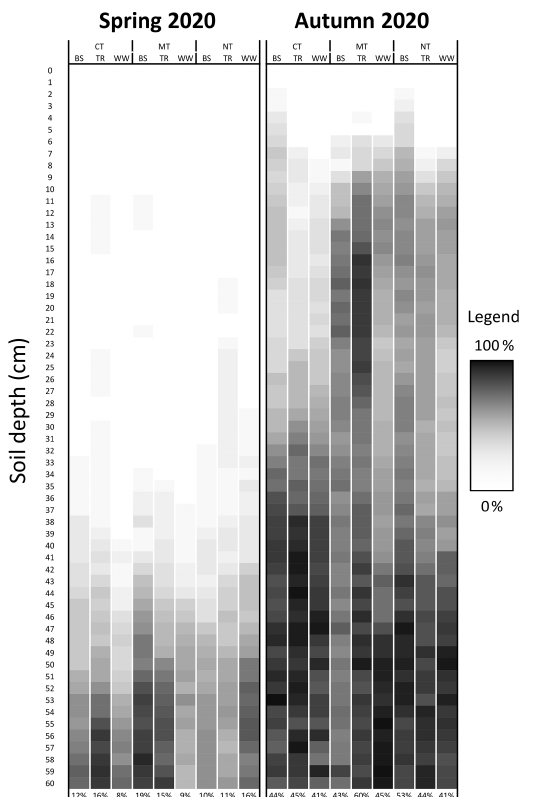
Figure 5. Percentage of the penetration resistance